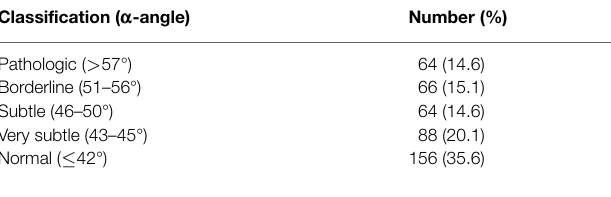
TABLE 1 | Distribution of ααα -angle .